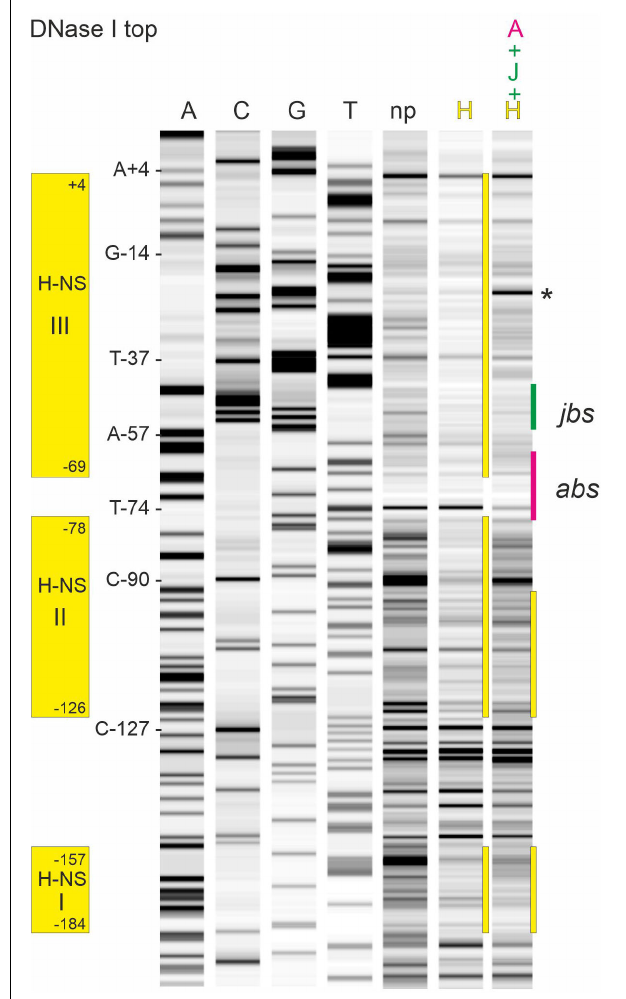
FIGURE 4 | DNase I footprinting of the R1P Y dsDNA fragment with the non-template strand fluorescently labeled reveals binding sites for H-NS, ArcA-P, and TraJ R1 in the R1P Y promoter region. Lanes A, C, G, and T are products of sequencing reactions with some of the bases indicated on the left side of lane A. np, DNA fragments obtained with DNase I digestion. H, DNA fragments obtained with 0.2 µ M H-NS before DNase I digestion. Three distinct regions with reduced band intensities are indicated by yellow bars. H-NS protected regions are indicated on the left side and correspond to three AT rich regions as shown in Figure 1B . Last lane shows DNase I fragments obtained in the presence of ArcA-P (0.4 µ M), TraJ R1 (5 µ M), and H-NS (0.2 µ M). The resulting change in the banding pattern suggests a replacement of H-NS from binding site III and partially from binding site II. Note the appearance of an additional prominent band between − 35 and − 10 regions in the P Y promoter (indicated by an asterisk). abs , binding site for ArcA-P; jbs , binding site for TraJ R1